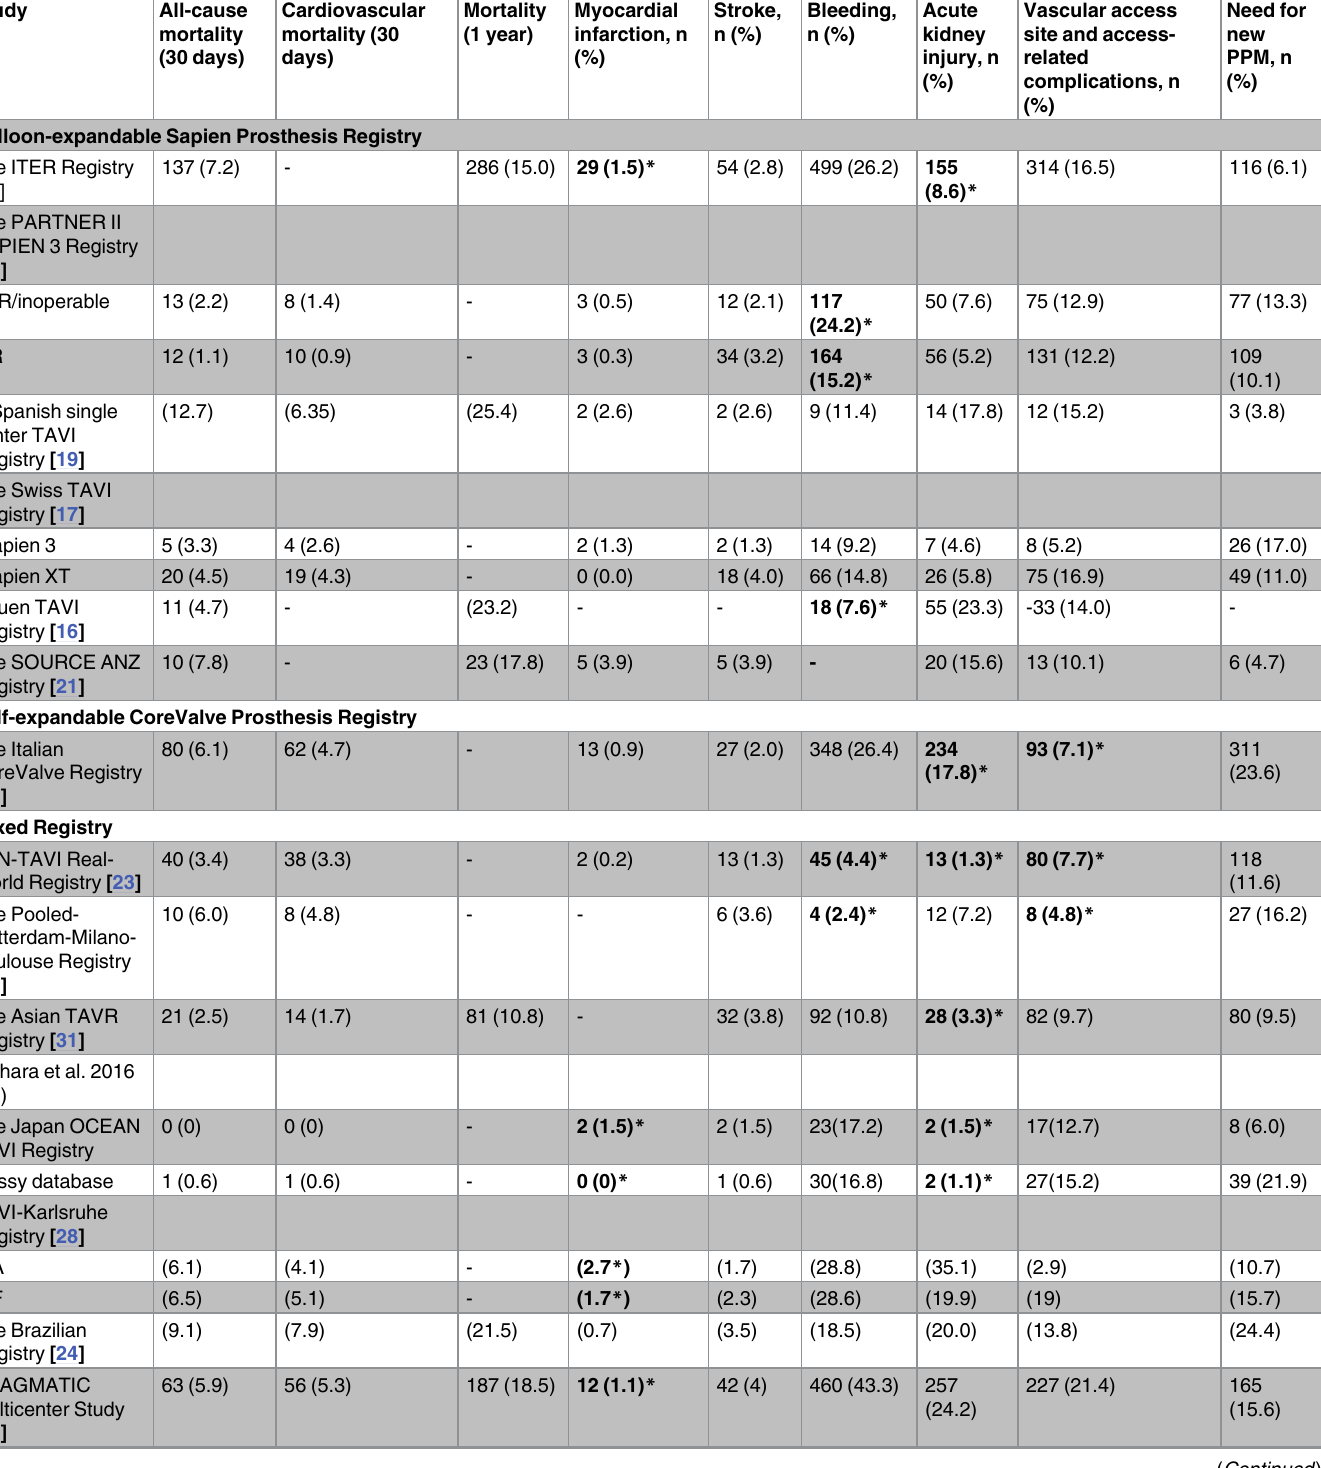
Table 3. Results of individual study based on VARC-2